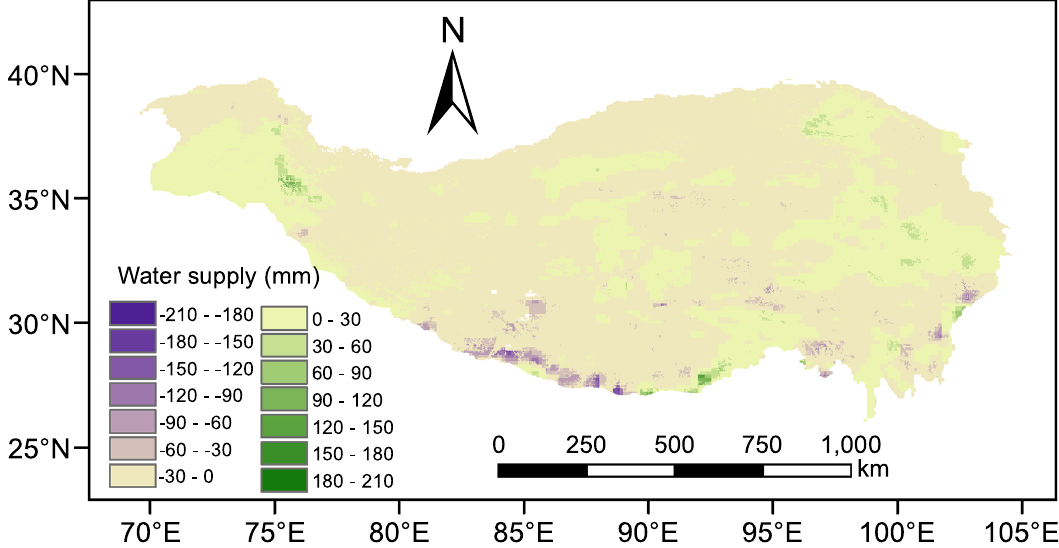
Fig. 5 | South Asian black carbon-initiatedaveraged summer water supply change over the Tibetan plateau for the period 2007 – 2016. The base map is generated based on the calculation using the Integrated Valuation of Ecosystem Services and Tradeoffs